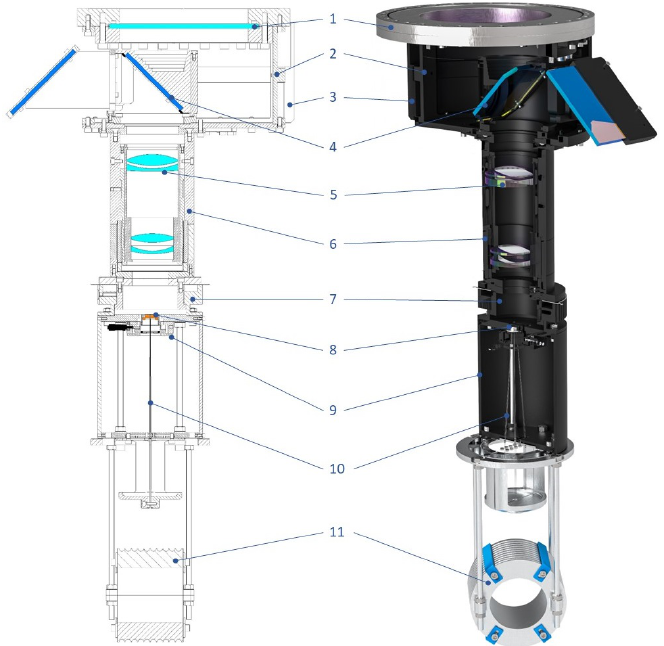
Figure 4. Section view of the optics system consisting of the vacuum window (1), optics holder (2), side closure (3), folding mirrors (4), objective (5), objective holder (6), rotating unit (7), fiber plate (8), fiber plate holder (9), optical fibers (10), and the fiber bundle holder